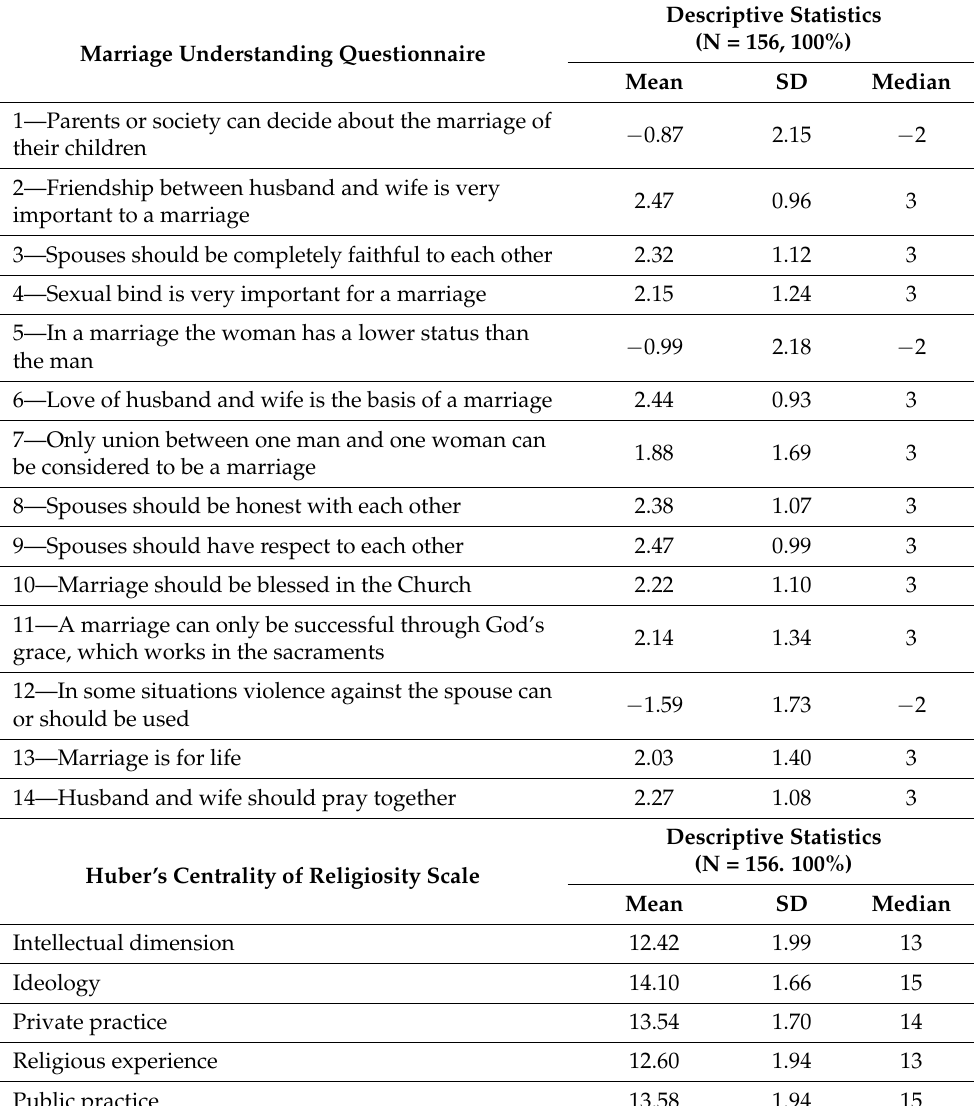
Table 1. Research tools—descriptive